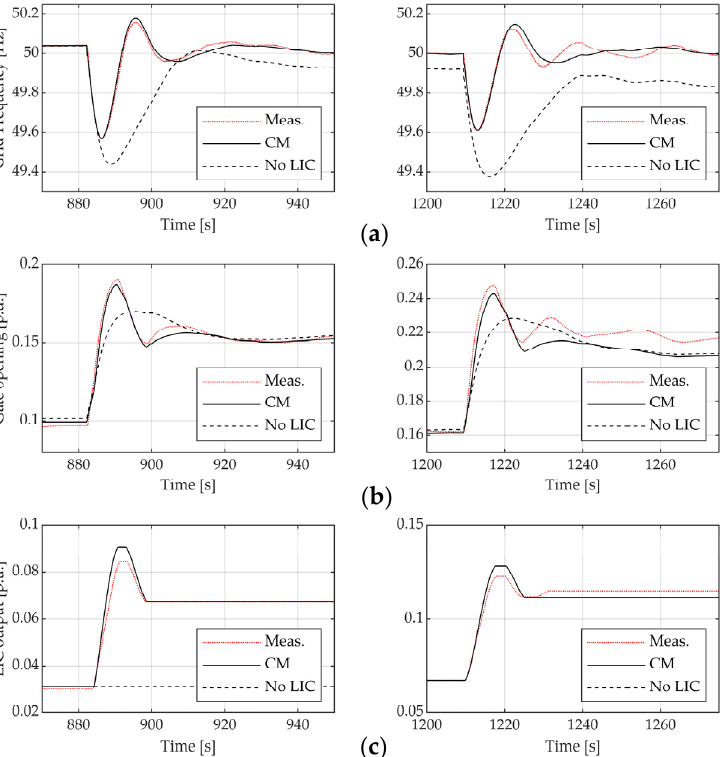
Figure 12. Comparison between simulation results and measurement recordings of the S L1 and S L2 events for ( a ) the grid frequency, ( b ) the gate opening of G1 and ( c ) the output signal of the LIC of G1, with and without the LIC model.